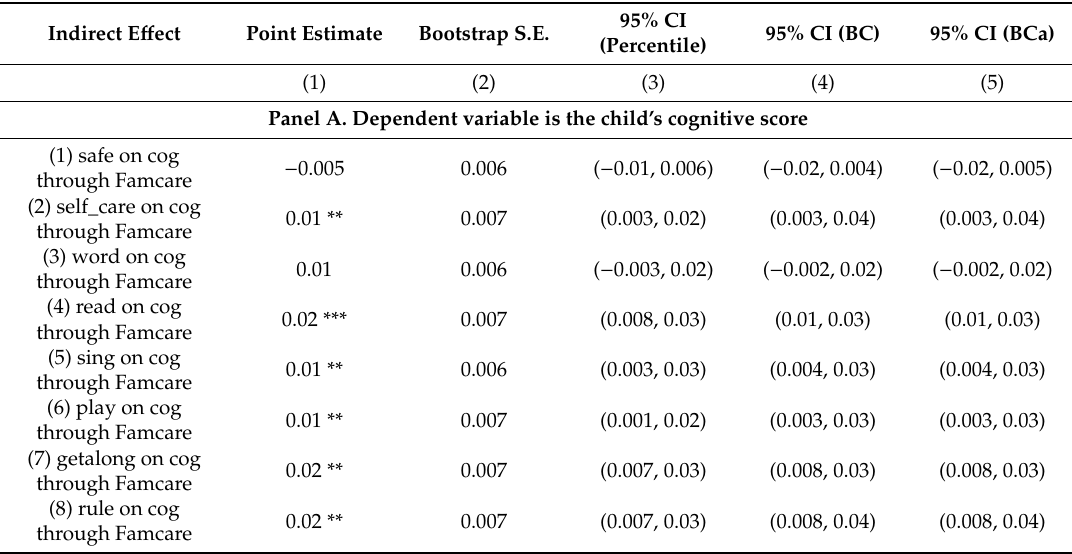
Table 4. Estimates of indirect e ff ects of di ff erent measurements of parenting information on child development through family